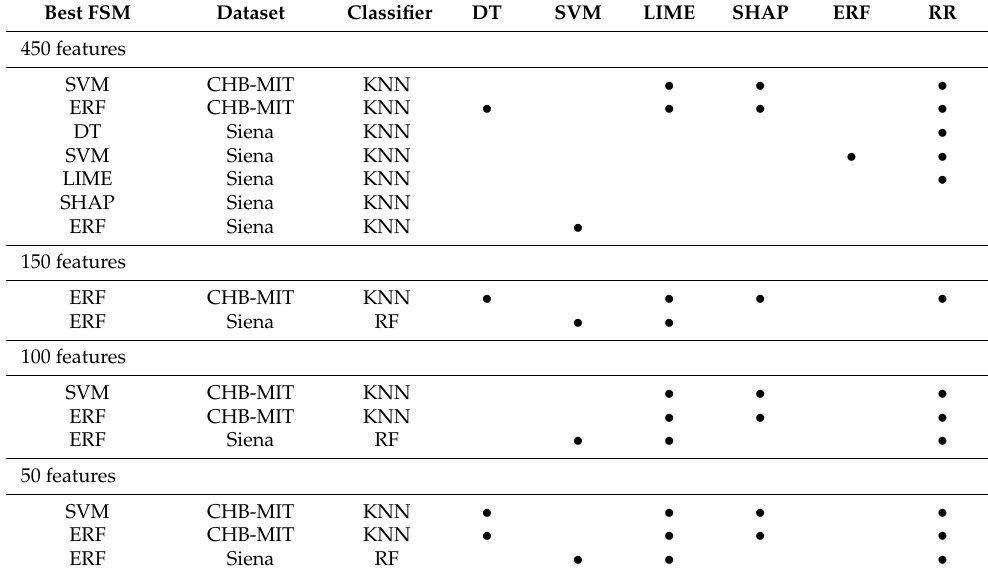
Table 11. Comparison of the best C-FSM when FS2 is used. It is compared against the rest of the FSMs. • denotes p <